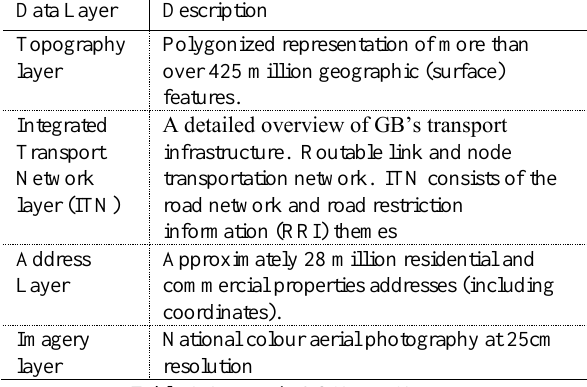
Table 1. Layers in OS